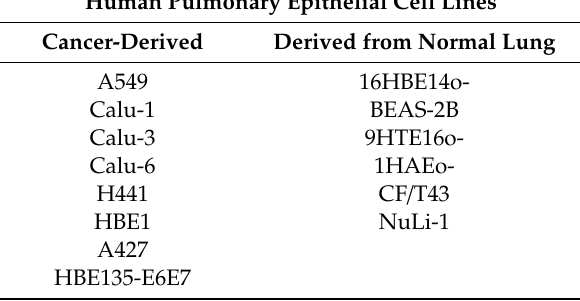
In vitro lung epithelial cell culture models to evaluate protein-loaded polymeric nanoparticles